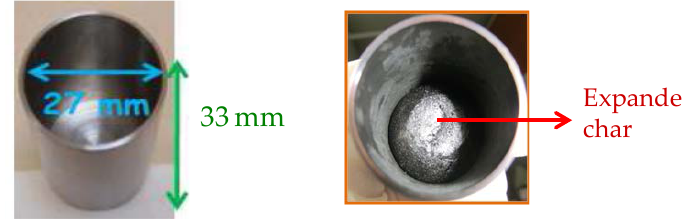
Figure 2. Sample holder used for the measurement of the expansion.